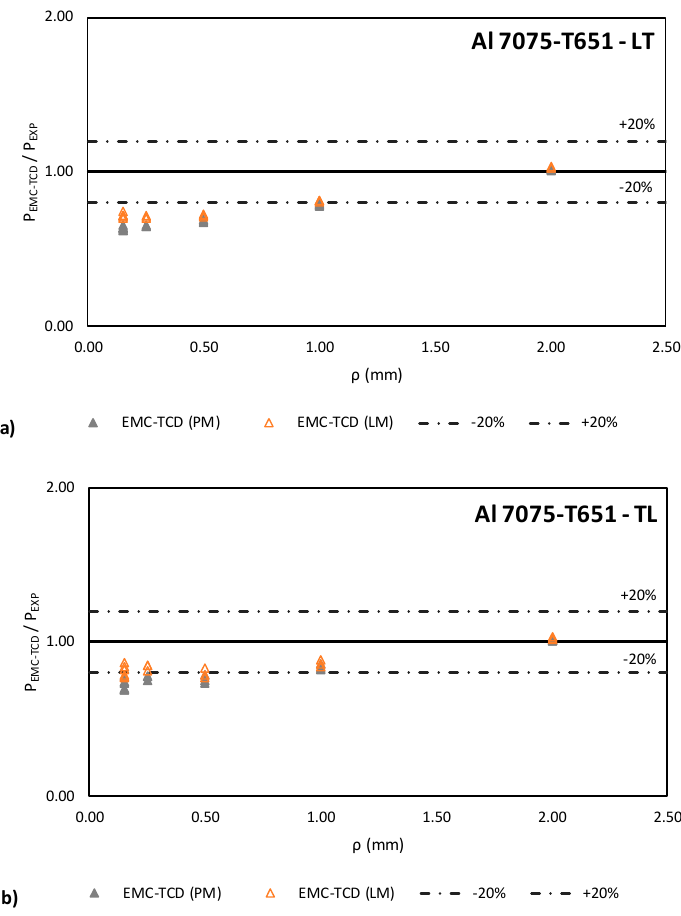
Figure 10. Comparison between fracture load predictions (EMC-TCD) and experimental fracture loads; ( a ) TL specimens; ( b ) LT specimens.